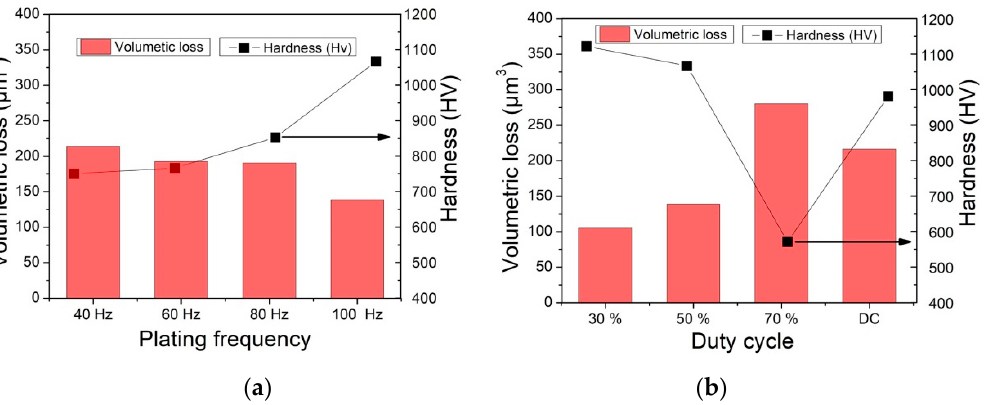
Figure 8. Effect of pulse frequency and duty cycle on the hardness and wear resistance, ( a ) varying by frequency at 50% duty cycle, ( b ) varying by duty cycle at frequency of 100 Hz.